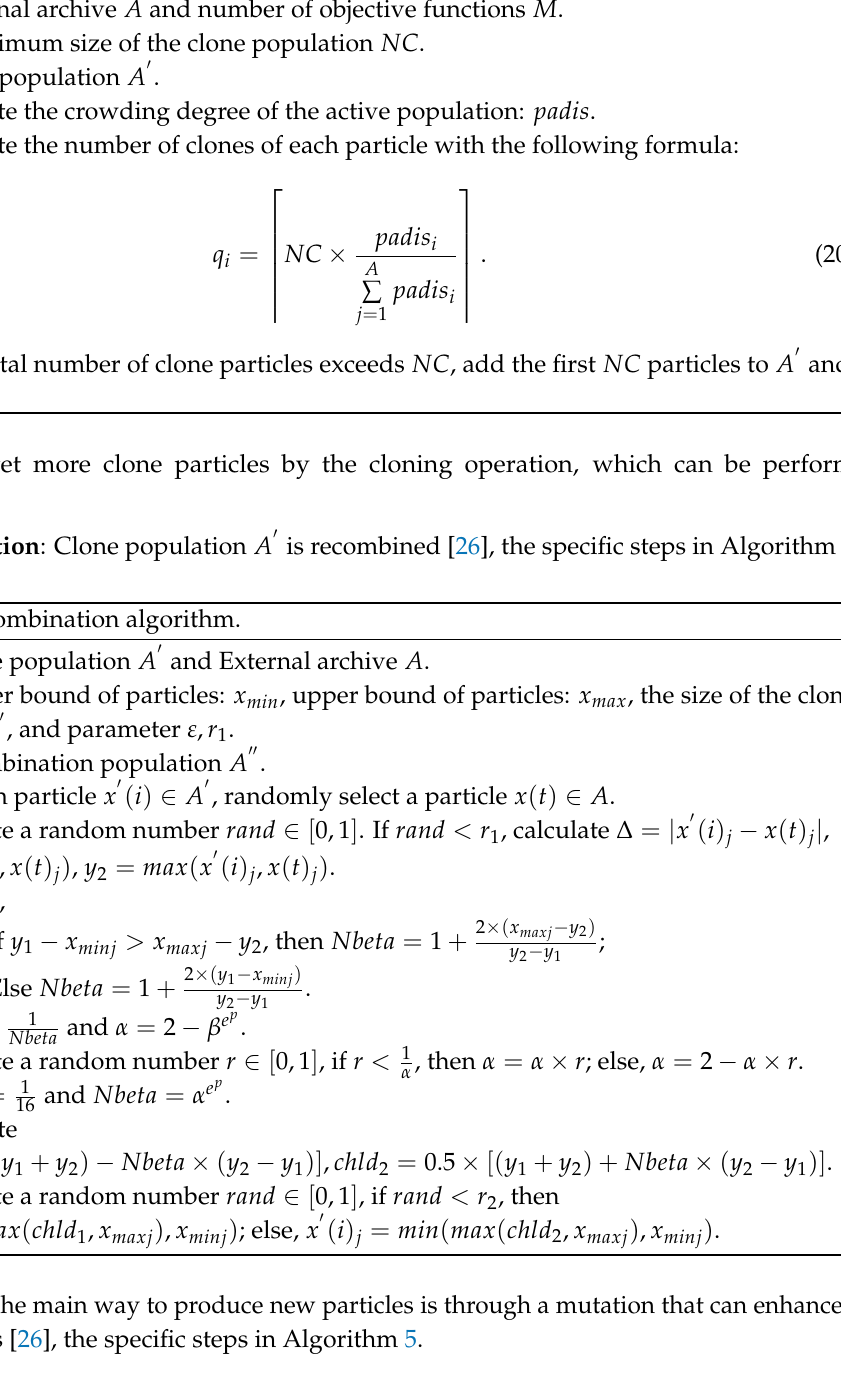
Algorithm 3: Clone algorithm.